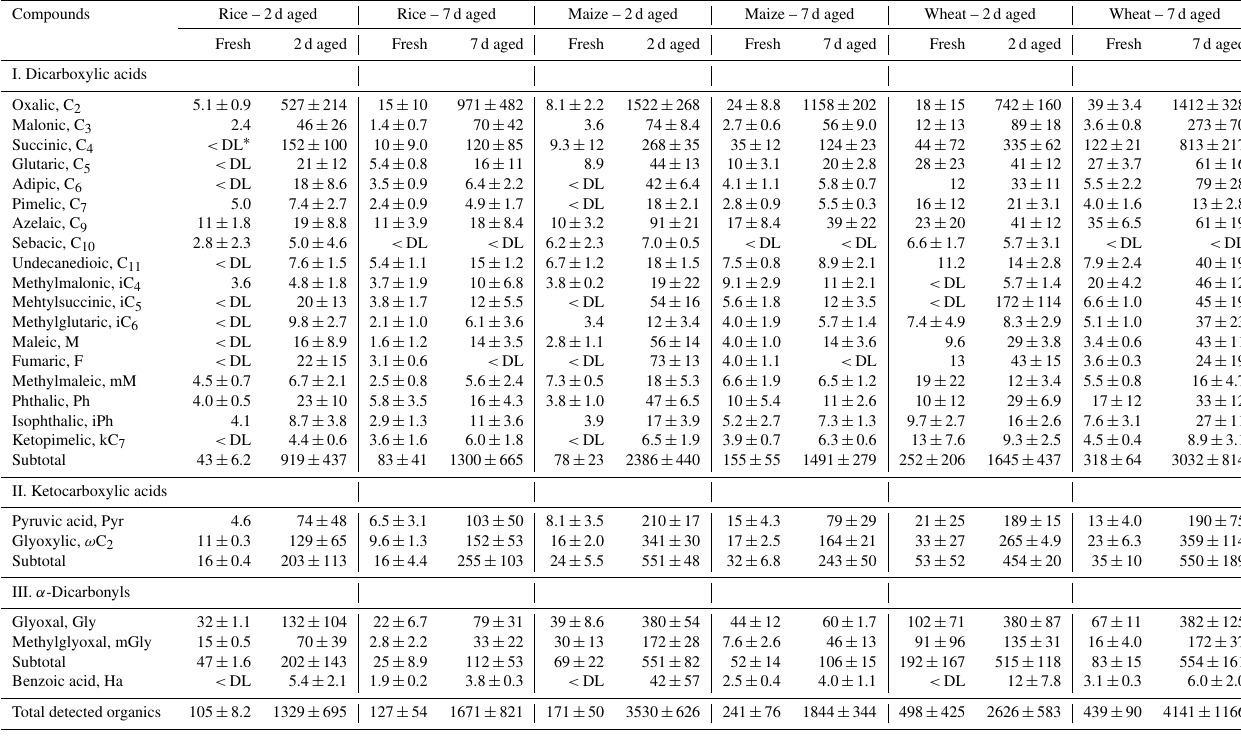
Table 1. Emission factors (EFs; mgkg − 1 ) of fresh and aged dicarboxylic acids and related compounds from rice, maize and wheat straw burning.